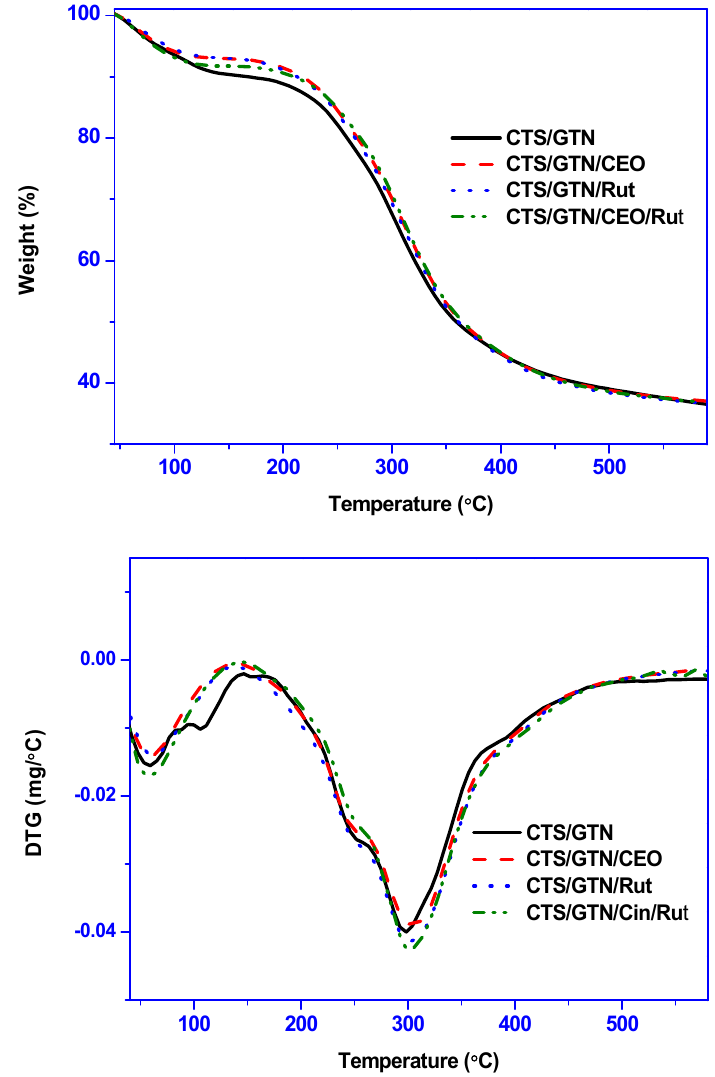
Figure 3. TGA and DTG thermograms of chitosan/gelatin-based films.